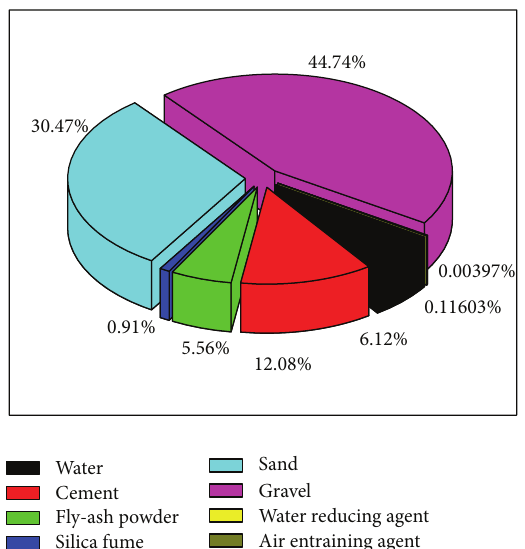
Figure 1: Standard constituents percentages of Sino high strength hydraulic concrete (with mass